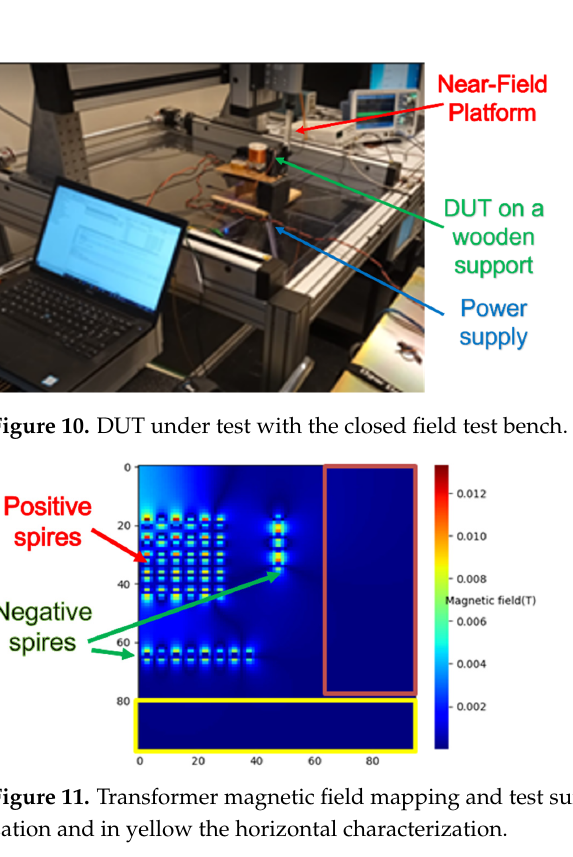
terization and in yellow the horizontal characterization. zation and in yellow the horizontal characterization.